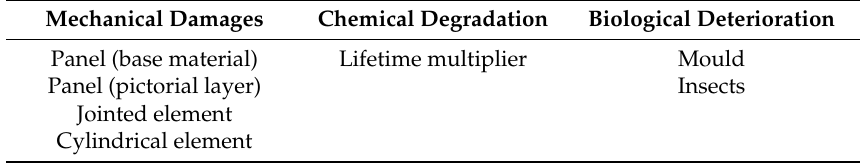
Table 3. The main variables to estimate indoor deterioration in wooden buildings.